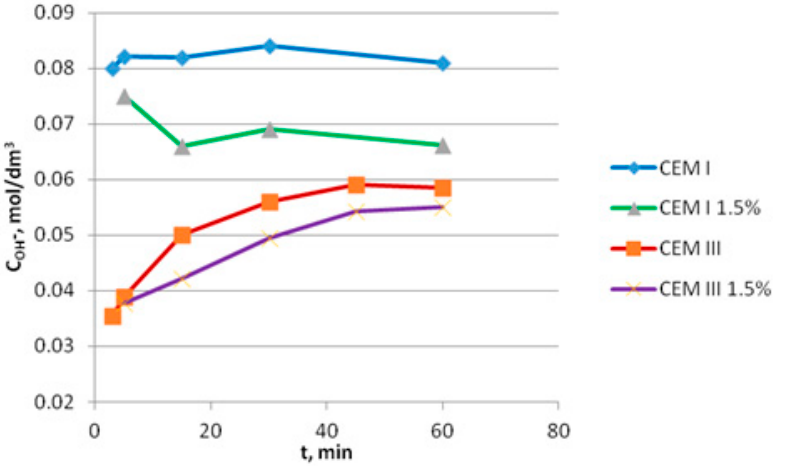
Figure 2. Changes in the OH − ion concentration during hydration of CEM I and CEM III cements without and with the admixture containing aluminum powder.